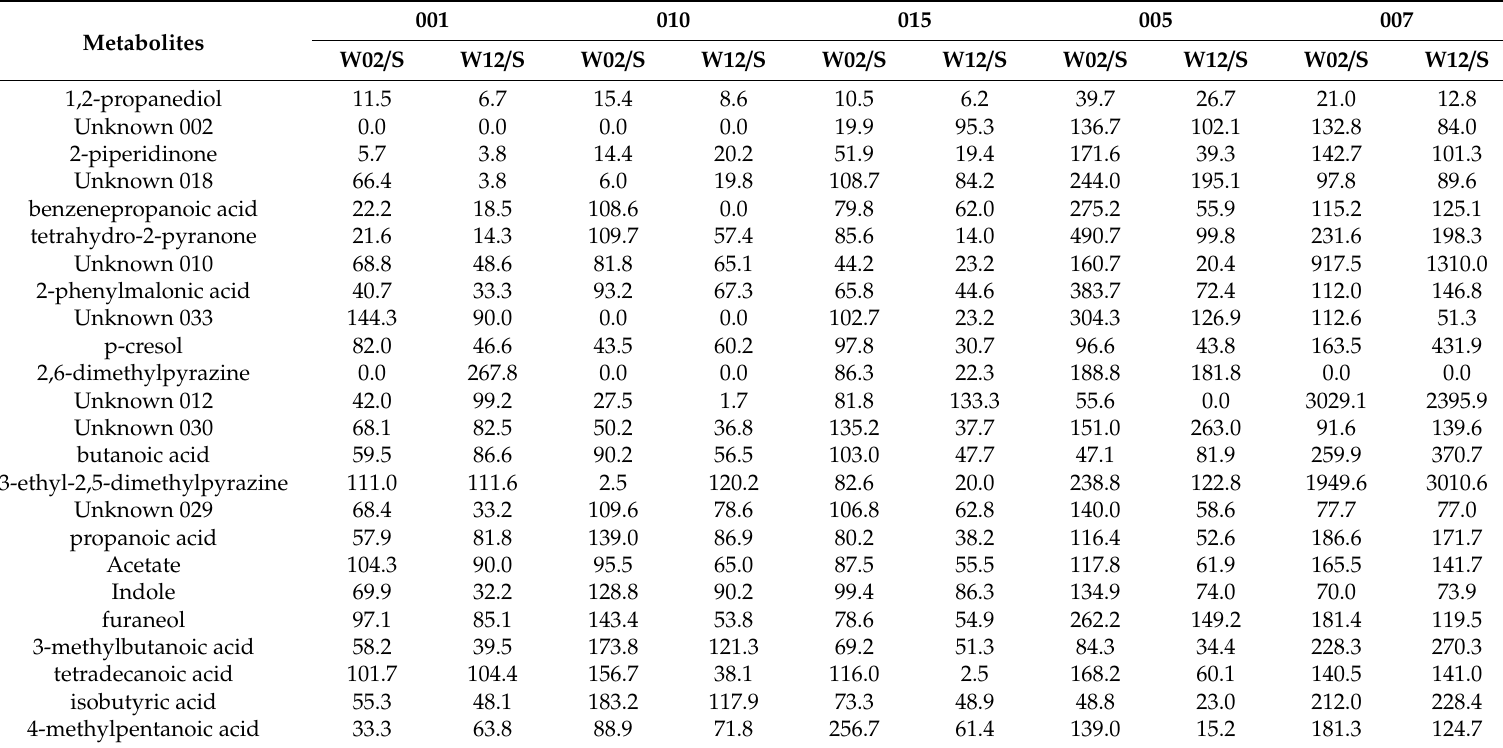
Table 3. Volatile metabolites with large changes in abundance across